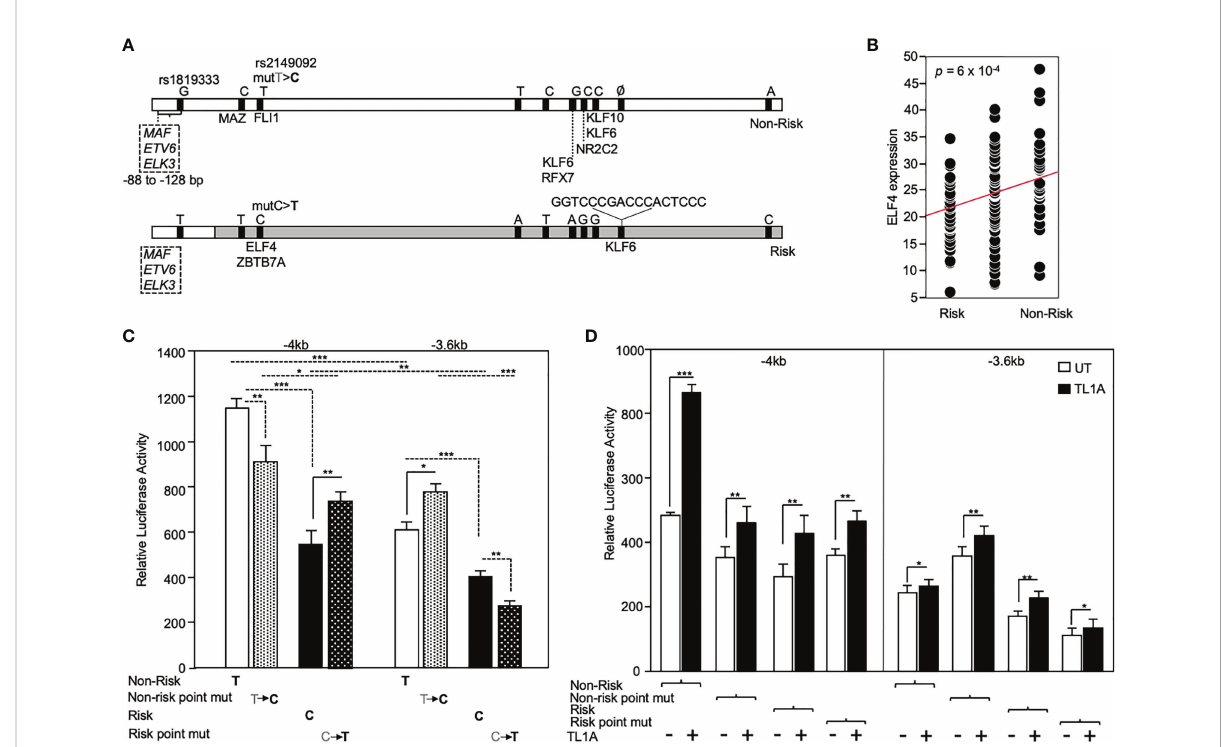
FIGURE 4 Functional analysis of RNASET2 promoterSNP variants. (A) Schematic illustrationof luciferase reporterconstructused to analyzefunctional contributionof riskand non-riskindex rs1819333 and regulatory rs2149092 variants onRNASET2 promoteractivity. Tick marks represent SNPs in LD with both rs1819333 tagging and rs2149092regulatory variants. Transcriptionfactors (TF) associated with both a putative SNP-dependent bindingsite and with RNASET2 eQTL riskcarriagearelisted. Boxed regiondirectly upstreamof rs1819333 depicts TF bindingsites for ETS family transcriptional repressors. (B) EQTL ELF4 expression vs. rs1819333 allelic carriage. (C, D) . CD4 + T cells weretransfected withpromoter-reporter vectors. (C) Resting (-4kb, n=16, -3.6kb, n =22) or (D) TL1A(-4kb, n =8, -3.6kb n=8 ) activatedcells. Data show the mean ± SD*** P < 0.001, ** P < 0.01; * P <